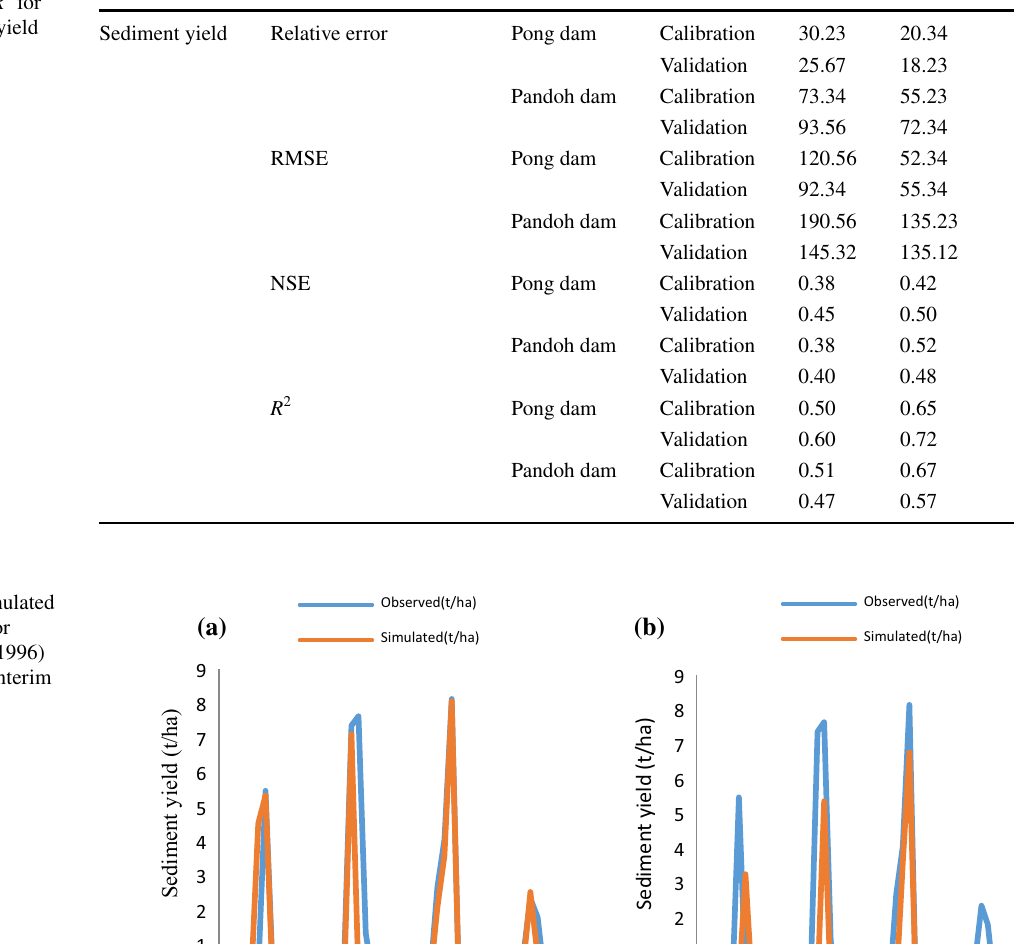
Table 5 Relative error (%), RMSE (m3/s), NSE and R 2 for simulated river sediment yield